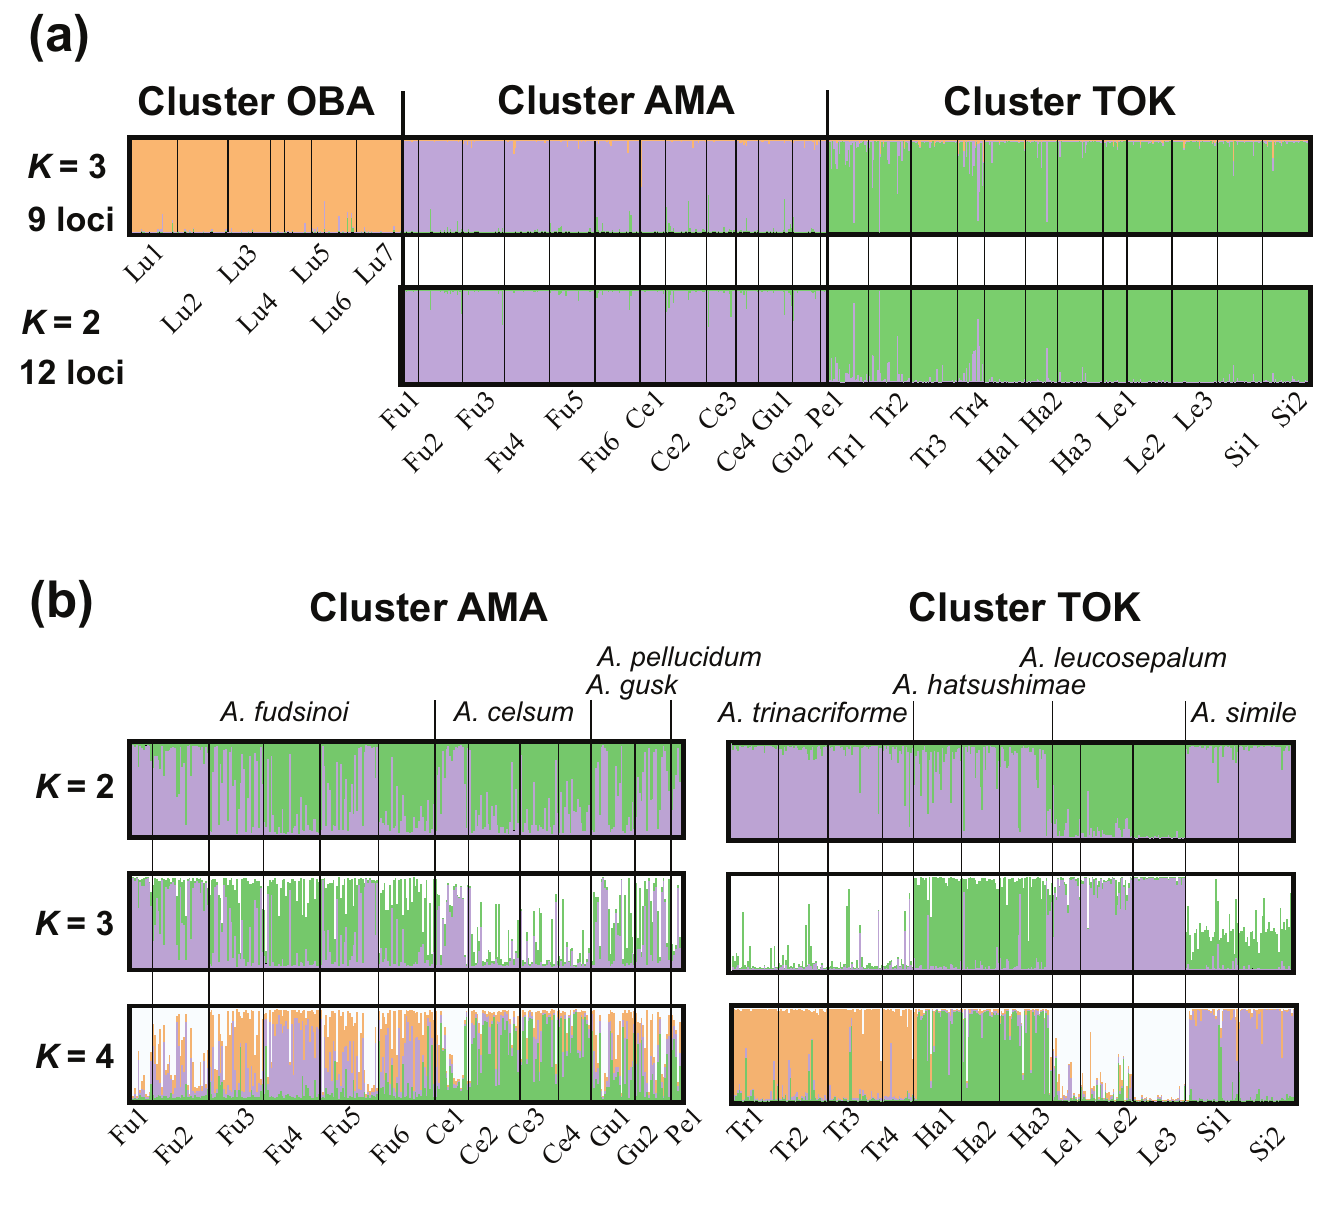
Fig 4. The results of Bayesianclustering analysis using the program STRUCTURE. (a) distributionof cluster membership. Top: analysisof all populationsbased on the nine core loci with K = 3, bottom: analysisof all populations other than those of A . lutchuense basedon 12 loci with K = 2; (b) Distributionof AMA and TOK cluster memberships for K values of